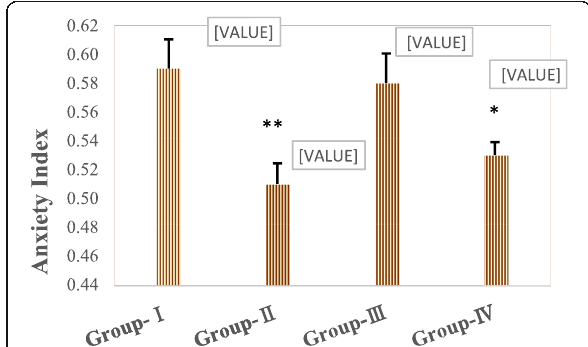
Fig. 1 Effect of Psidium guajava Linn leaves extract on anxiety index. Group I = control group, group II = positive control group, group III = Psidium guajava Linn low strength group, group IV = Psidium guajava Linn high strength group. * p < 0.05, ** p < 0.01 vs group